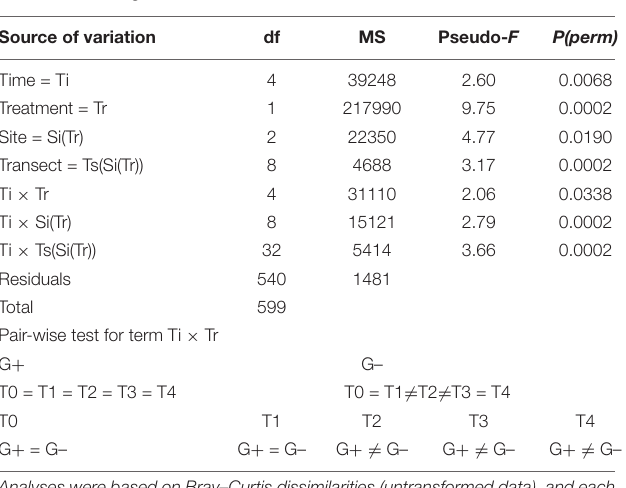
TABLE 1 | Results of permutational multivariate analysis of variance (PERMANOVA) testing the effect of sea urchin culling on the structure of benthic assemblages.